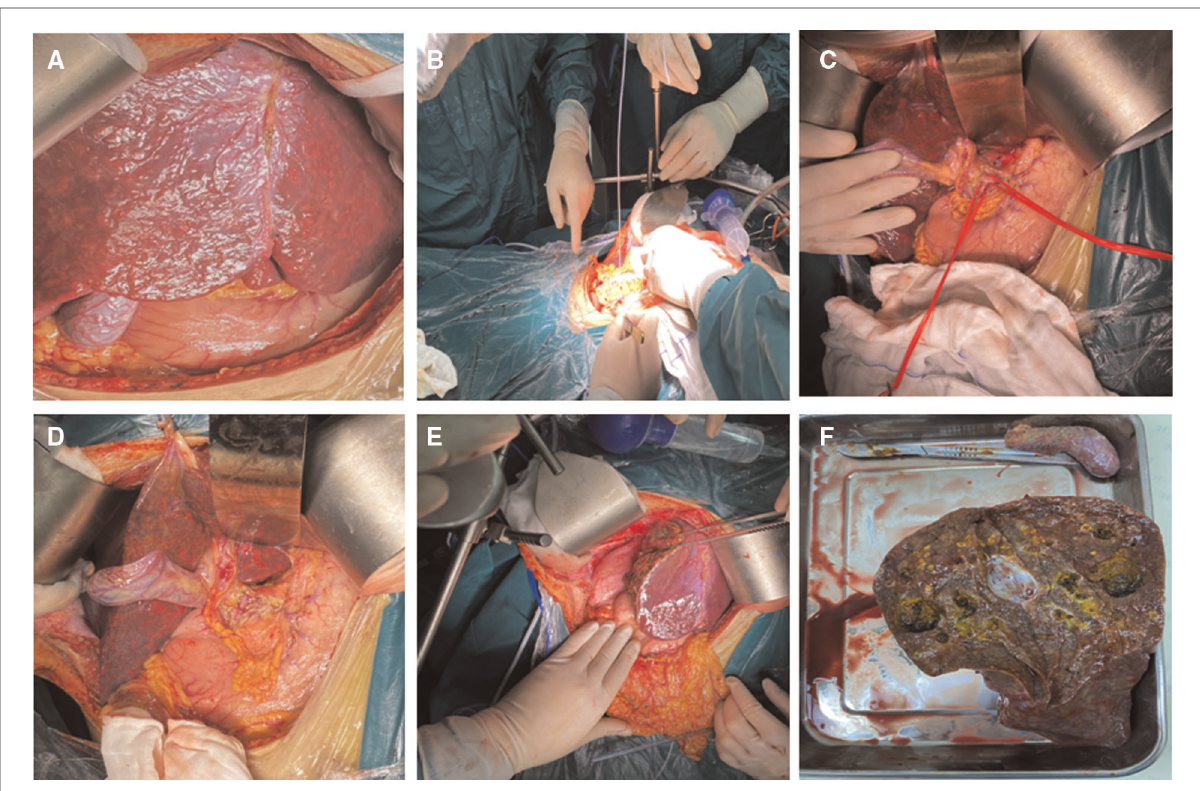
FIGURE 2 The operative procedure and key intraoperative pictures. ( A ) Surgical exploration revealed extensive telangiectasia in the liver; ( B ) Portal venous pressure measurement prior to the surgery; ( C ) The common hepatic artery and gastroduodenal artery were suspended and pre-occluded; ( D ), The common hepatic artery and gastroduodenal artery were ligated; ( E ) Right hemihepatectomy was performed successfully; ( F ) Right liver specimen and intrahepatic bile duct dilatation with stone